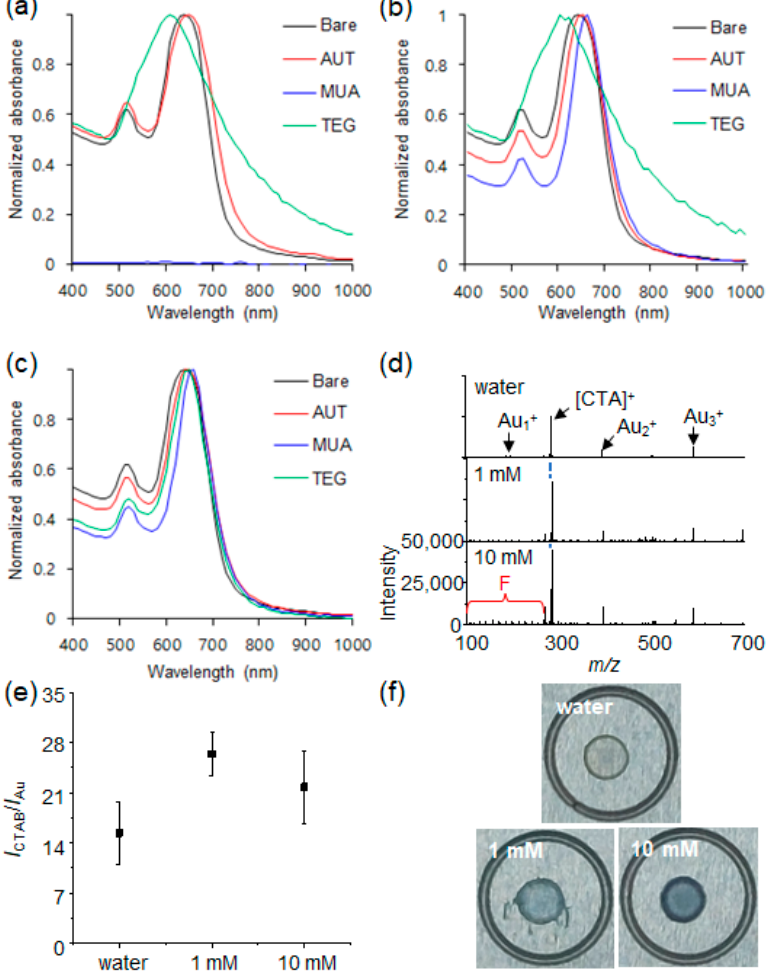
Figure 3. UV–Vis spectra of AUT-, MUA-, and TEG-modified Au NRs in ( a ) water, ( b ) 1 mM CTAB, and ( c ) 10 mM CTAB. ( d ) LDI-TOF-MS spectra of the modified Au NRs with different concentration of free CTAB. ( e ) The intensity ratio of the mass peaks from [CTA] + and Au cluster ions obtained from Au NRs re-dispersed in water and 1 mM and 10 mM CTAB solutions. ( f ) Photographs of the spots formed on a target plate by evaporation of a single droplet of the re-dispersed Au NRs in water and 1 mM and 10 mM CTAB solutions.